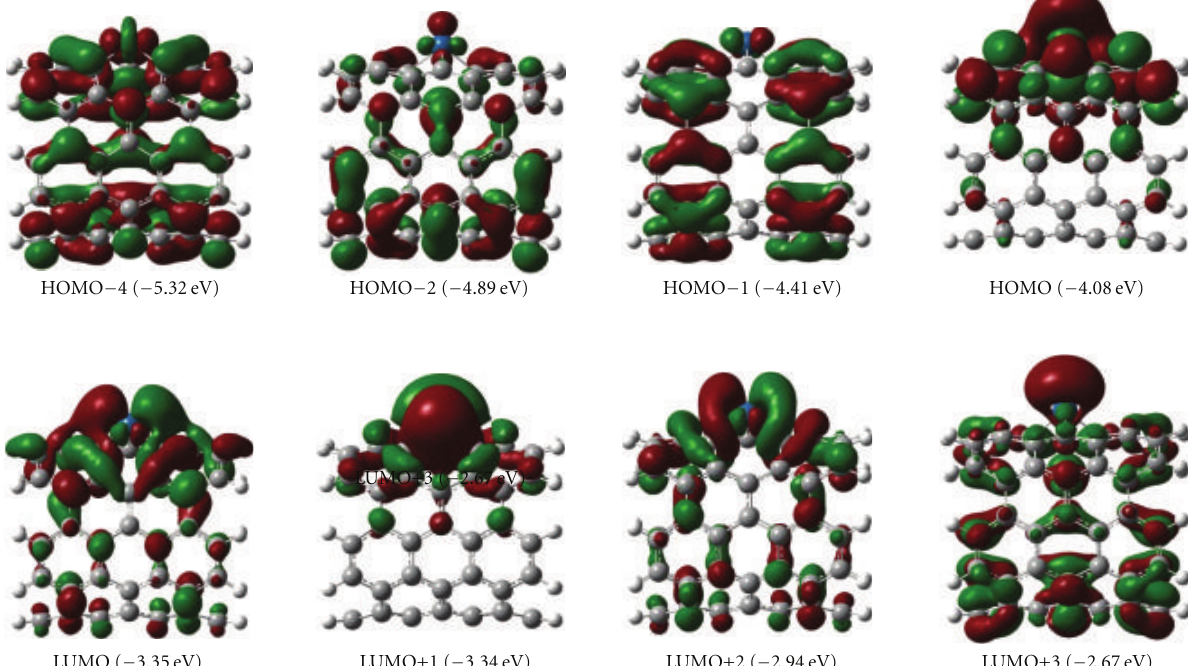
Figure 16: Relevant MOs for ground-state C 69 H 20 Pt. Orbital energies are in parentheses